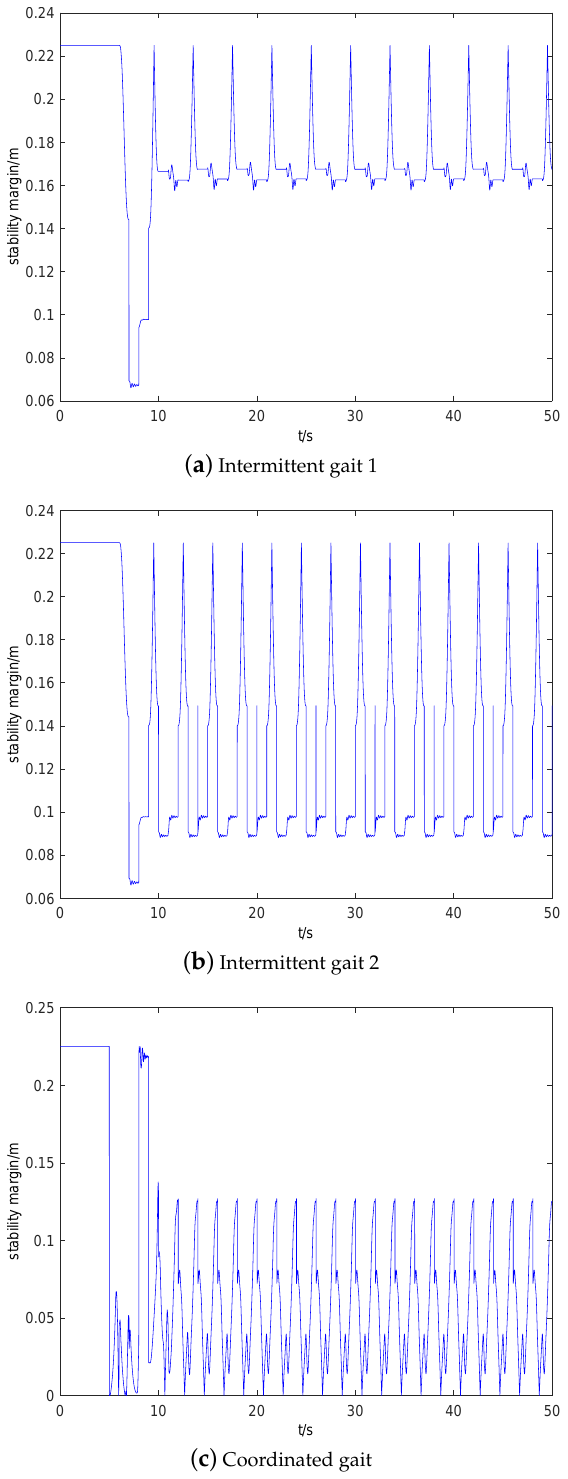
Figure 9. Comparison of the stability margin of three static